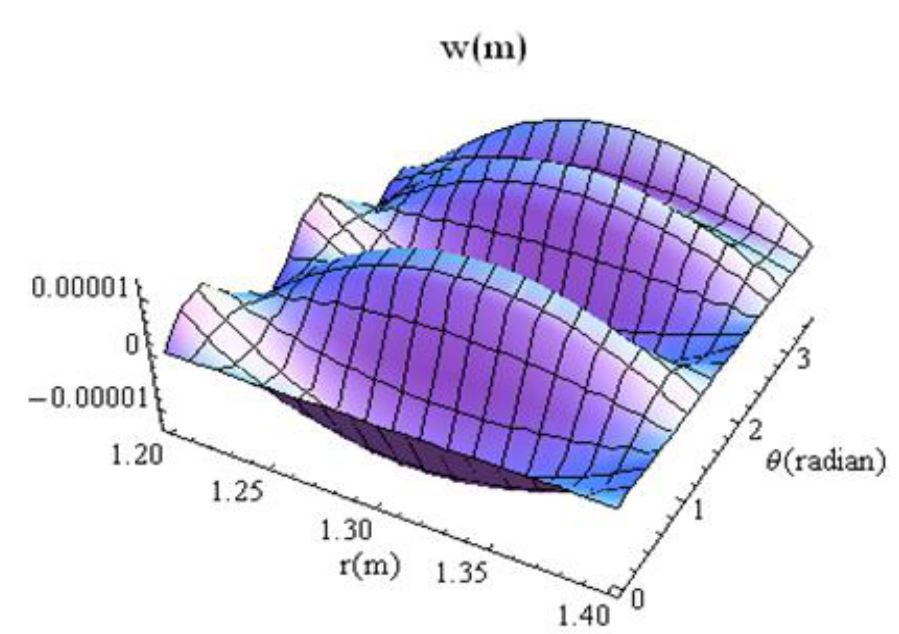
1122 | Vol. 6, No. 4, 2021